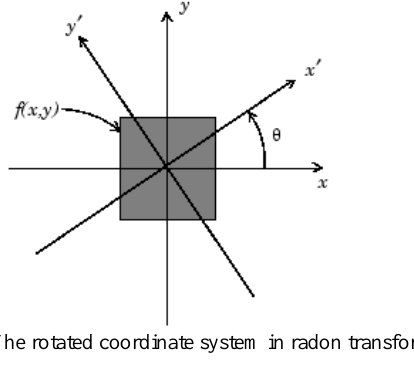
Figure 2. The rotated coordinate system in radon transform